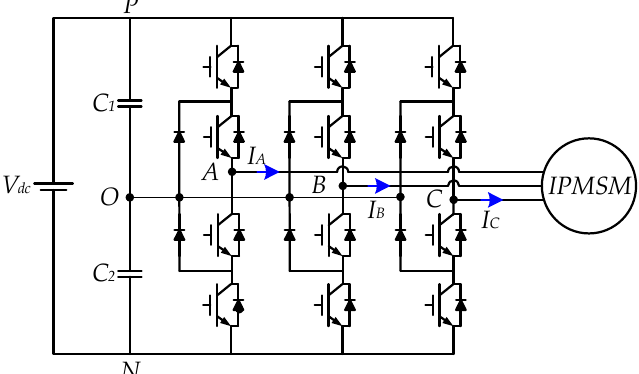
Figure 3. Standard circuit topology of the three-level neutral-point clamped (NPC) inverter.